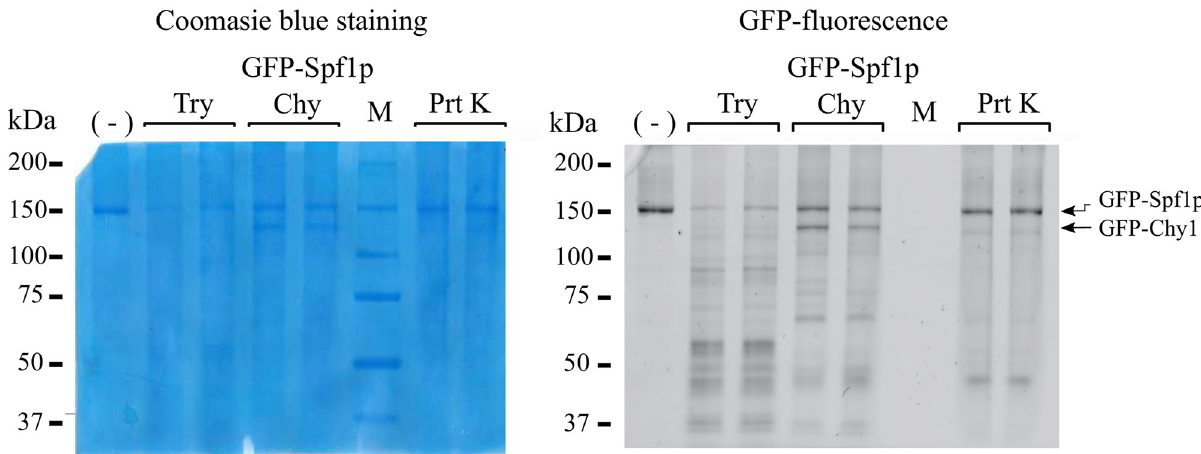
Fig 2. In-gel fluorescence analysis of the GFP-Spf1 digests. 1.5 μ g GFP-Spf1 was exposed for 5 min at 28˚C to the action of the indicated protease as described under “Materials and methods”. GFP-Spf1p: protease ratio (w/w) was Try , trypsin: (5:1), Chy , chymotrypsin (20:1) and Prt K , proteinase K (20:1), and the reaction was stopped by the addition of 12 μ g or 3 μ g of aprotinin for trypsin and chymotrypsin respectively. Proteinase K digestion was stopped by the addition of 0.5 mM PMSF. The panel on the left shows the Coomasie blue stained gel and on the right the measurement of GFP fluorescence. Two lanes from duplicate proteolysis reactions for each protease are